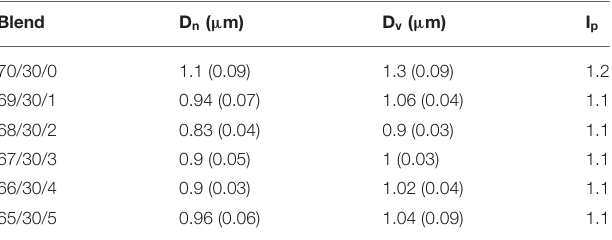
TABLE 3 | Number-average and volume-average PA12 droplet diameters (D n and D v ), PA droplet size polydispersity (I p ) with standard deviation in brackets of PLA/PA12/PLA-g-MA blends.